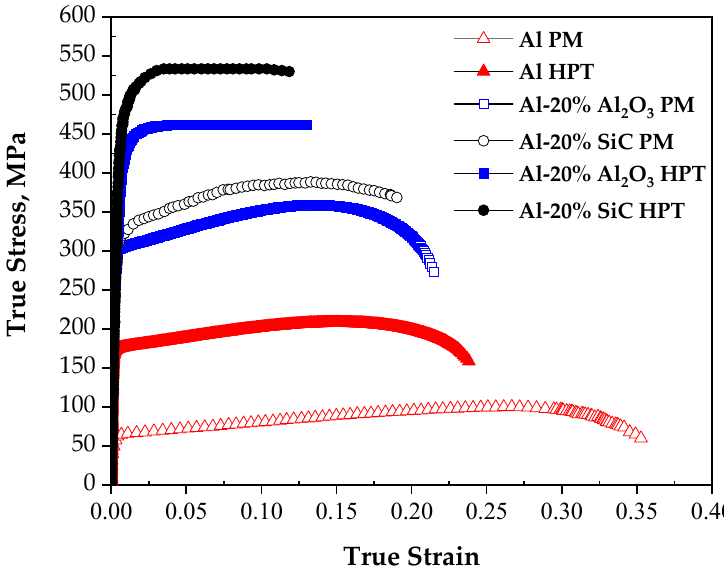
Figure 9. The true stress–true strain curves of the different samples. The formation of the Al MMCs effectively increases the tensile strength of the PM Al samples by 72–74% due to the secondary and geometrically necessary dislocation and HPTed Al MMCs tensile strength increase can be explained by the two mean reasons. First is the influence of the dislocations, including secondary and geometrically necessary dis- locations. Second, the grain boundaries strengthen through HAGBs according to the Hall– Petche relationship and low-angle grain boundaries (LAGBs). The higher tensile strength of the HPTed Al MMCs over those of the PM samples is due to the higher dislocation density related to the SPD. Moreover, the effect, the HAGBs, and LAGBs contribute to